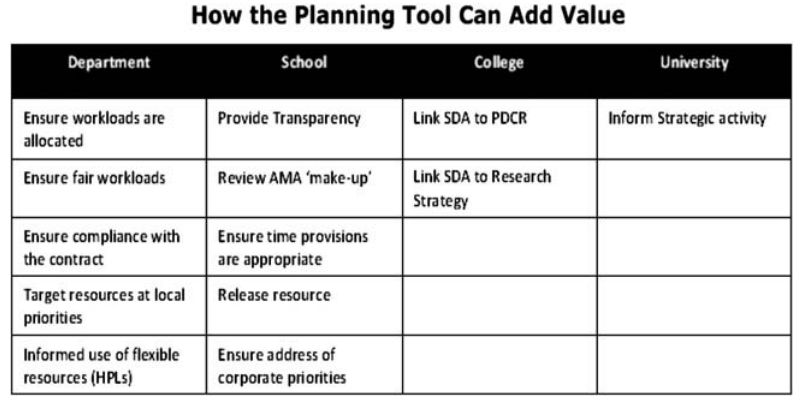
Figure 7. Discussion points for evaluating the workload tool introduced at